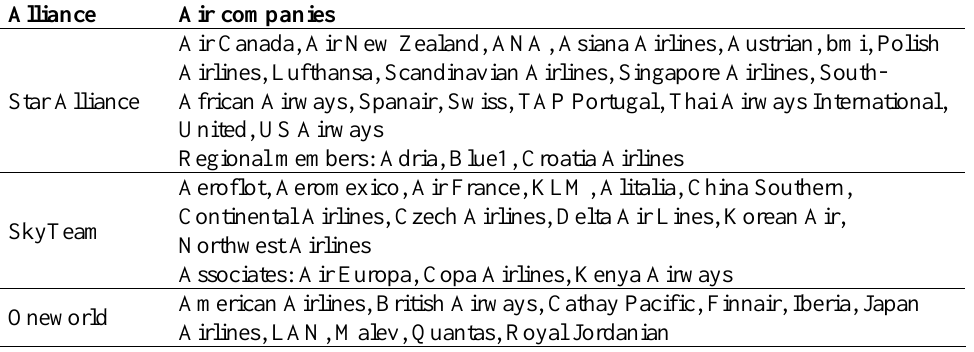
Table 4. Composition of strategic alliances (2007) Alliance Air companies Star Alliance